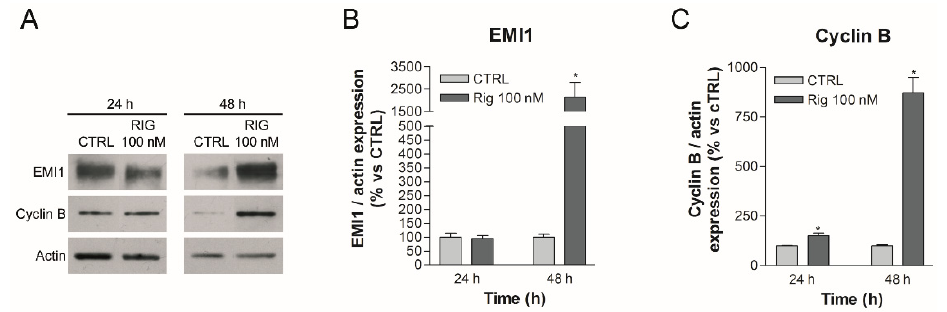
Figure 2. Western blot analysis of EMI1 and cyclin B in EGI-1 cells treated with Rig. ( A ) Representative images of EMI1, Cyclin B and actin after treatment with 100 nM Rig for 24 and 48 h. ( B ) The graph represents the quantification of EMI1 western blot, normalized to actin. ( C ) The graph represents the quantification of cyclin B western blot, normalized to actin. All the graphs are represented as the mean percentage ± SD of at least three independent experiments and are compared to untreated controls arbitrarily set to 100%. * p < 0.05 vs. CTRL.